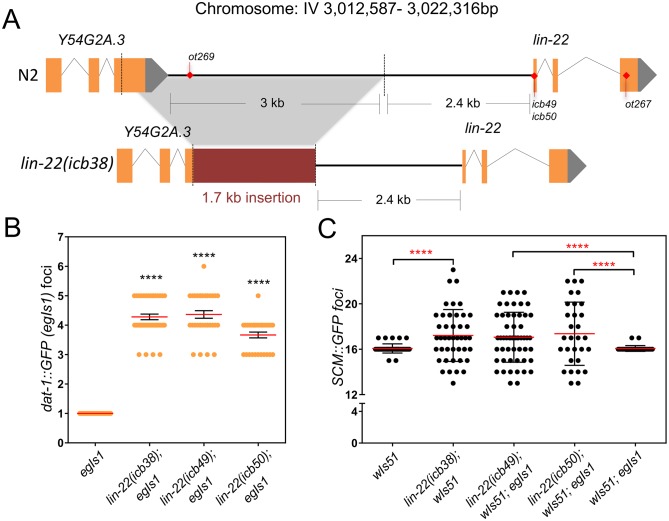
The icb38 mutation represents a loss of function mutation in lin-22.(A) Illustration of the lin-22(icb38) mutation, which is a 3,329 bp deletion removing part of the distal lin-22 promoter (2,371 bp upstream of the lin-22 ATG). The deletion also removes part of the third exon and 3′ UTR of the upstream gene Y54G2A.3. The deleted part is replaced by a 1,733 bp insertion consisting of exon 7 and parts of introns 6 and 7 of the downstream gene mca-3. The position of other lin-22 alleles described in the manuscript is shown on the wild-type sequence. (B) Quantification of the number of PDE neurons (dat-1∷GFP foci) in the EMS-derived lin-22(icb-38) mutant and CRISPR-derived lin-22 mutants (n ≥ 30). Reference sample is egIs1 containing only the marker. (C) Quantification of seam cell number in lin-22(icb38) and other CRISPR-derived lin-22 mutants (n ≥ 30). Note an increase in seam cell number variance in lin-22 mutants depicted with red stars. Black stars show statistically significant changes in the mean with one-way ANOVA followed by the Dunnett test, and red stars depict changes in variance with a Levene’s median test (in both cases, **** corresponds to P value < 0.0001). Error bars show mean ± SEM (B) or mean ± SD (C). Numerical data used for Fig 2B, C can be found in S2 Data. CRISPR, Clustered Regularly Interspaced Short Palindromic Repeats; EMS, ethyl methanesulfonate; GFP, green fluorescent protein; PDE, post-deirid; scm, seam cell marker; UTR, untranslated region.